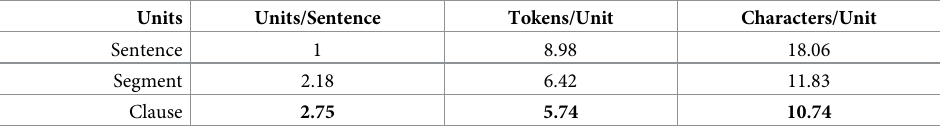
Table 7. Granularity of three